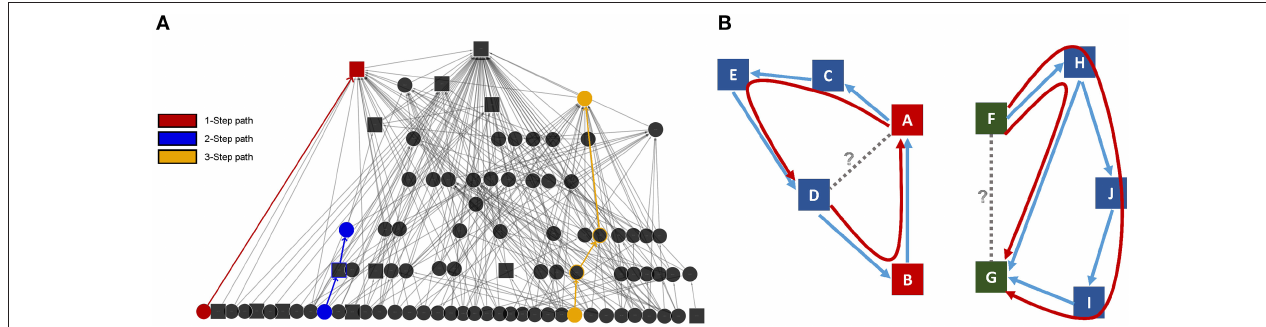
FIGURE 2 | Percolation and Conductance uses indirect pathways to determine consistency in a network. (A) Behavioral network illustrating direct (blue) and indirect pathways (yellow, red). (B) Low consistency from A to D represented by green and red arrow indicates an ambiguous dominance relationship. The high consistency from F to G represented by green arrows indicates high certainty that F outranks